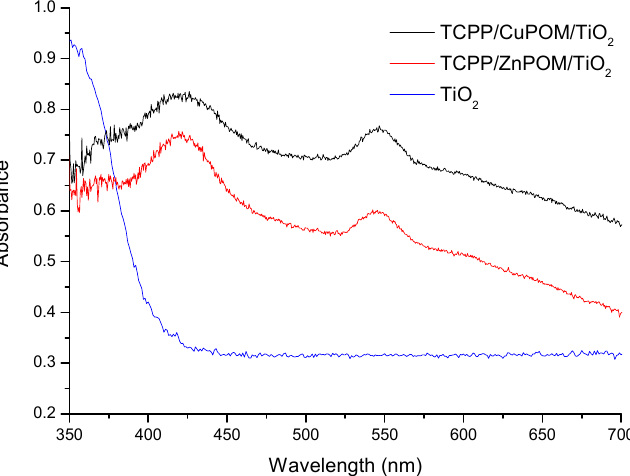
Figure 4. Reflectance diffuse spectra of the studied materials.